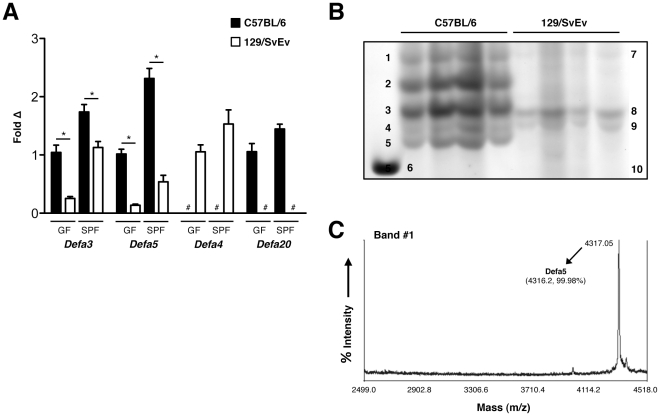
B6 and 129 mice exhibit distinct patterns of ileal α-defensin expression.(A) mRNA expression of α-defensin isoforms in the ileum of B6 and 129 GF and SPF mice (n = 7/group). Copy number is normalized to Gapdh (*P<.05, # - not detected). (B) AU-PAGE demonstrates peptide expression patterns of α-defensin isoforms in the ileum of B6 and 129 SPF mice. First lane is recombinant Defa4 control; each additional lane represents an individual mouse. Individual bands (based on calculated mass determined via mass spectrometry): 1-Defa5; 2-Defa24, Defa27; 3-Defa20, Defa21; 4-Defa2; 5-Defa22; 6-Defa4 (recombinant); 7-Defa5; 8-Defa2/18v, Defa11, Defa16, Defa21; 9-Defa18, Defa25; 10-Defa4. (C) Representative mass spectrum for band #1. Mass data for all gel bands are summarized in Table S1.